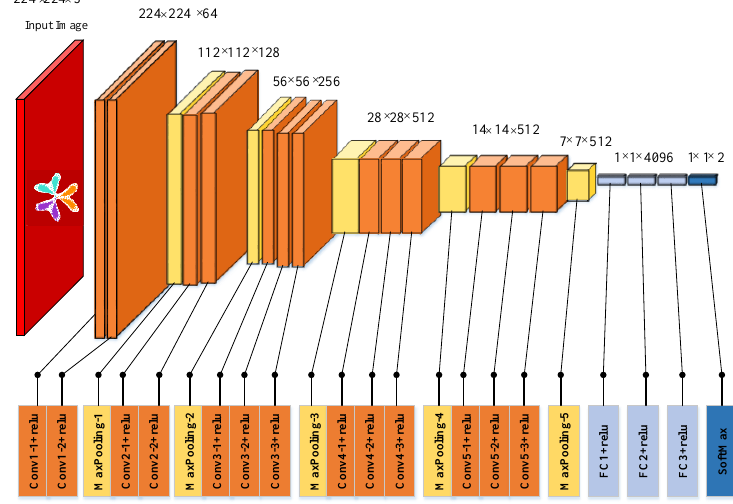
Figure 2. Architecture of the VGG16 convolution neural network.